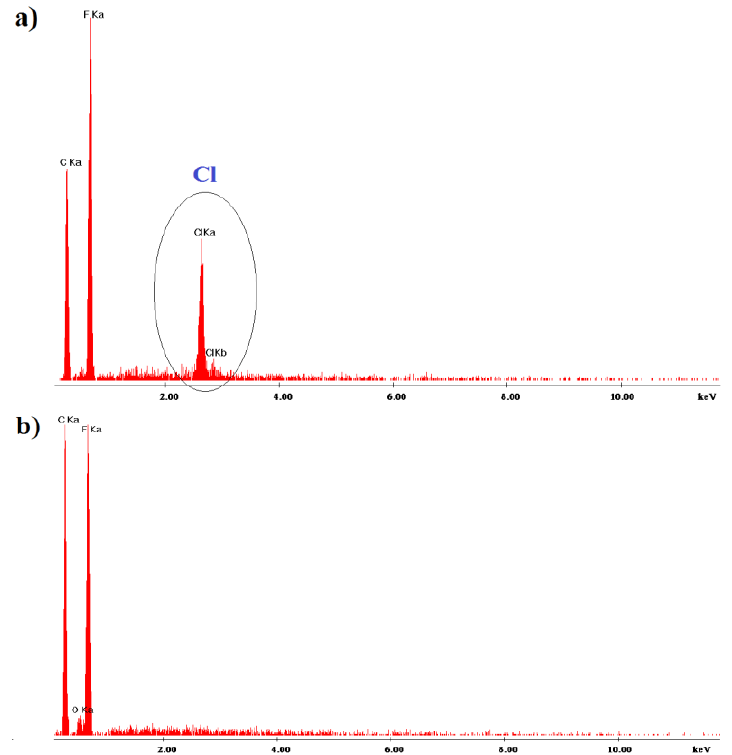
Figure 1 . EDS spectra of the polystyrene membranes, ( a ) non-conditioned, ( b ) conditioned membrane in 0.1 mol L −1 NaHCO 3.